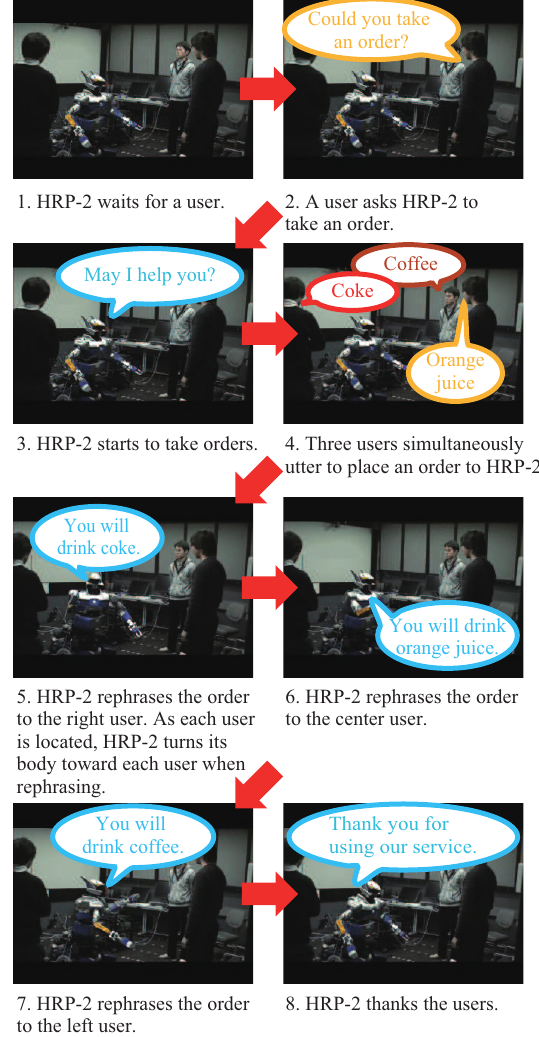
Figure 12. Snapshots of a meal order taking